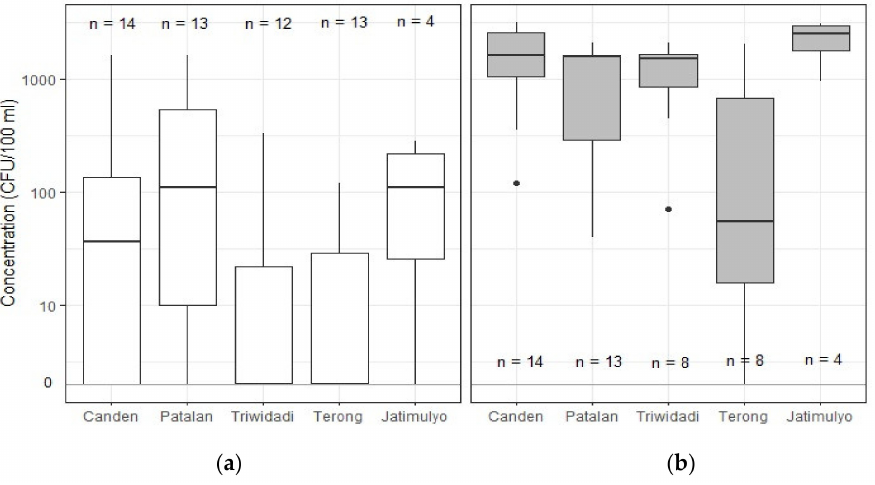
Figure 5. Microbial quality of groundwater in each village: ( a ) E. coli and ( b ) TC